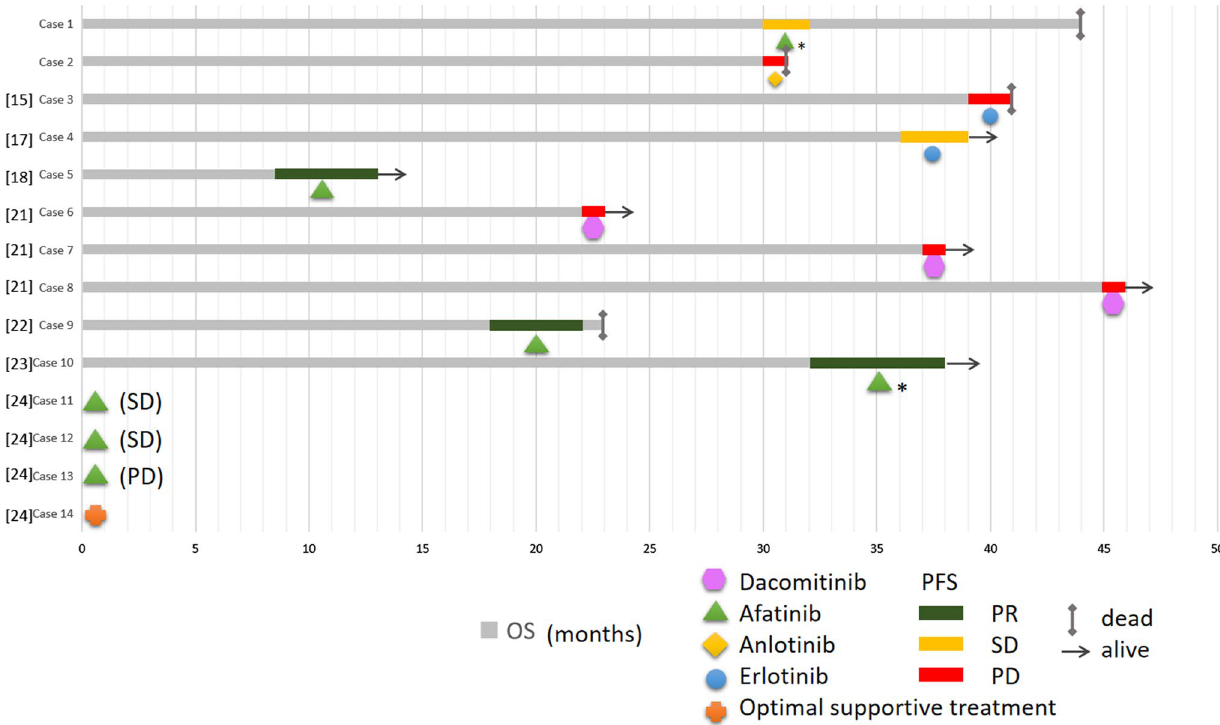
Fig. 3 Medication to the L718Q/V mutation in exon 18 of EGFR and prognosis (OS and PFS) of ten patients. Overall survival (OS) is repre- sented by the gray line segments, whereas progression free survival (PFS) is represented by the colorful line segments. Each grid represents a month. * stands for targeted therapy in combination with other treatments, such as chemotherapy or radiation. The PFS and OS for cases 11–14 are not shown in the figure because there was no relevant data in the